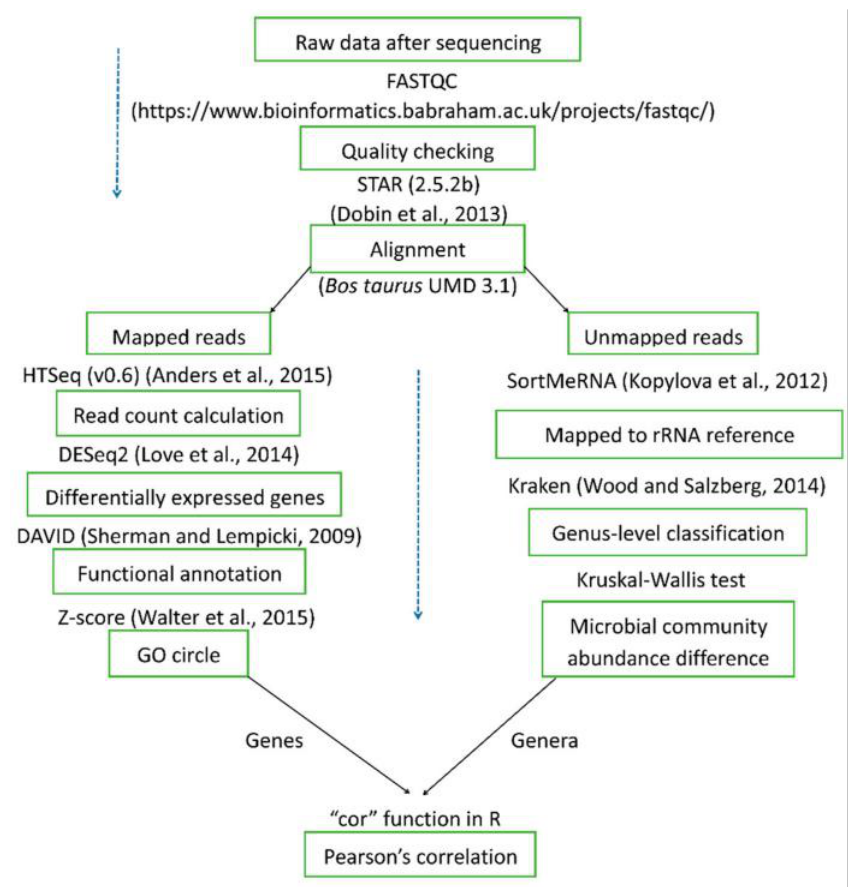
Figure 8. Bioinformatics workflow of whole-transcriptome sequencing data